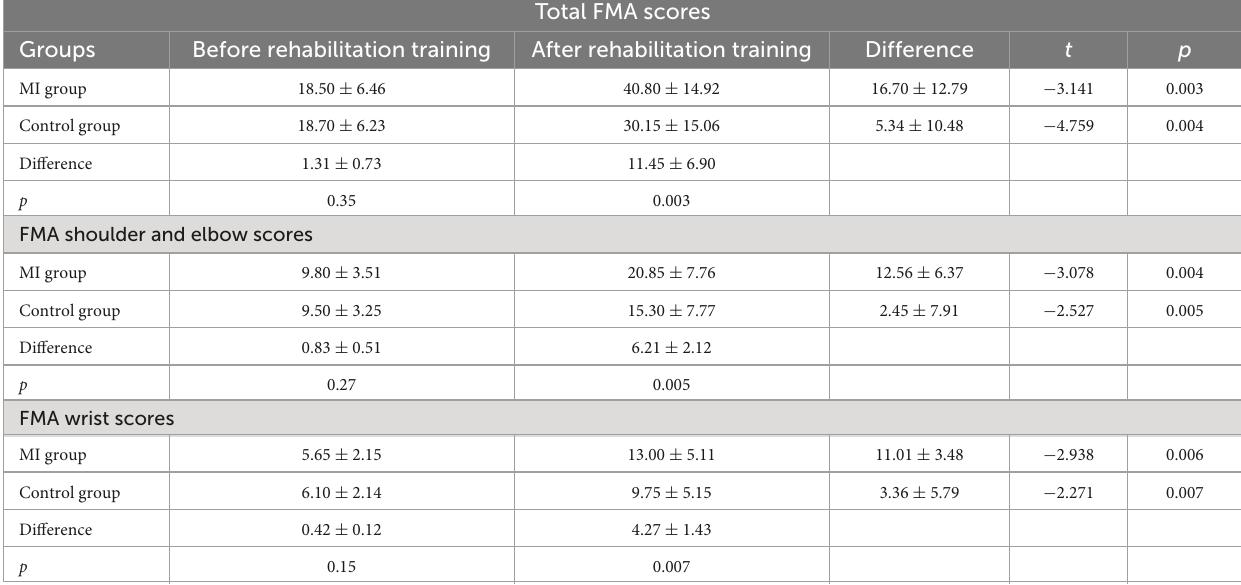
TABLE 2 Comparison of total FMA scores between the MI and control